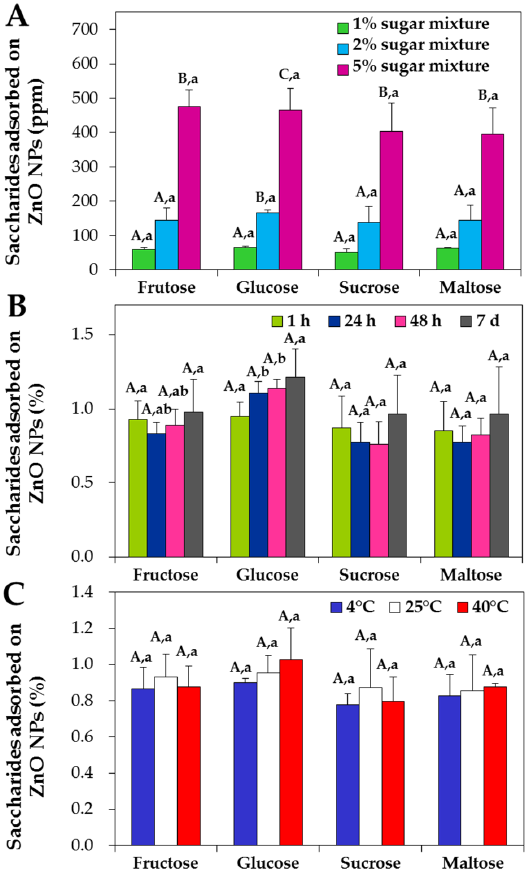
Figure 7. High performance liquid chromatography (HPLC) analysis of the interactions between ZnO NPs and saccharides in sugar mixtures with respect to ( A ) sugar concentration after incubation for 1 h at 25 °C, ( B ) incubation time in 5% sugar mixture at 25 °C and ( C ) temperature after 1 h in 5% sugar mixture. Sugar mixtures contain equivalent amounts of fructose, glucose, sucrose and maltose. Different capital letters (A–C) indicate significant differences in adsorbed amounts of each saccharide ( A ) between sugar mixture concentrations, ( B ) between incubation times and ( C ) between temperatures, respectively ( p < 0.05). Different lower-case letters (a,b) indicate significant differences between saccharide types ( A ) at the same concentration, ( B ) after the same incubation time and ( C ) at the same temperature, respectively ( p < 0.05).